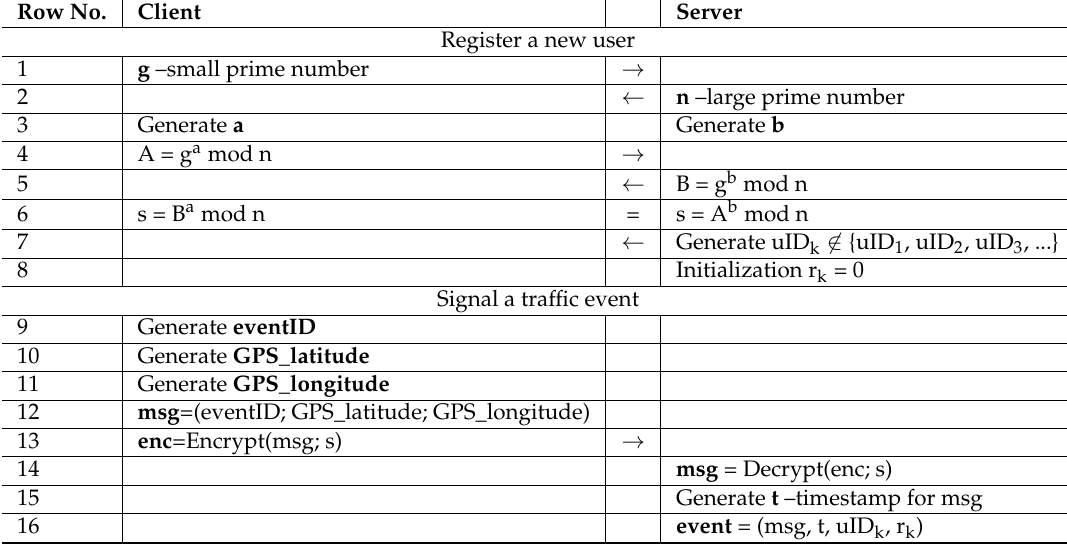
Table 2. Mathematical model describing the operations used to register a new user and to signal an event in traffic. Row